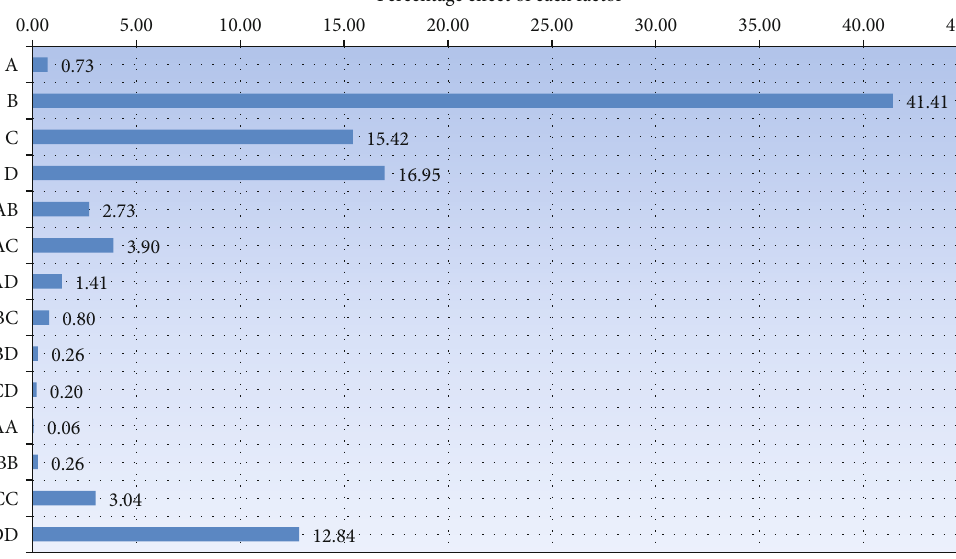
Figure 8: Pareto chart of the main e ff ects of each term on the removal of